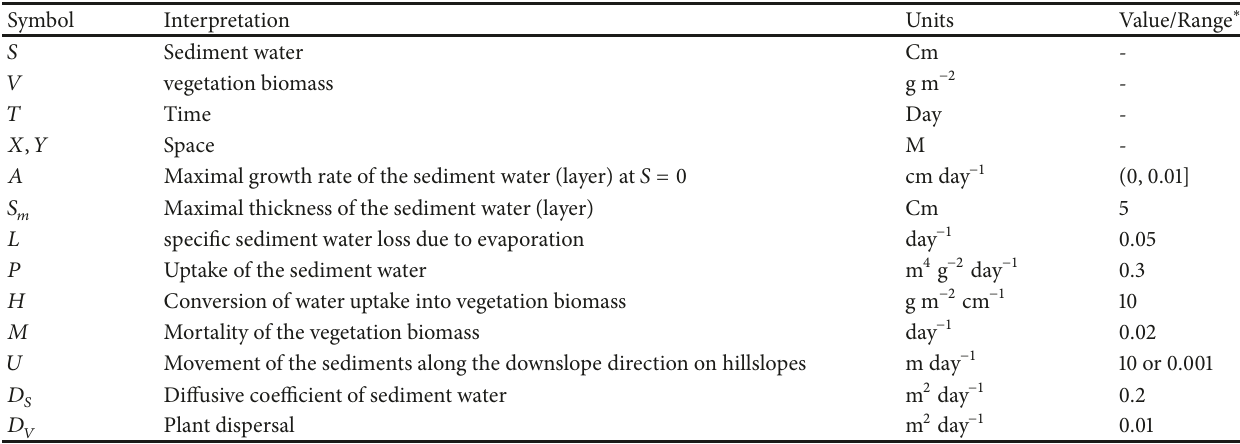
Table 1: Interpretation of the symbols used in (1a) and